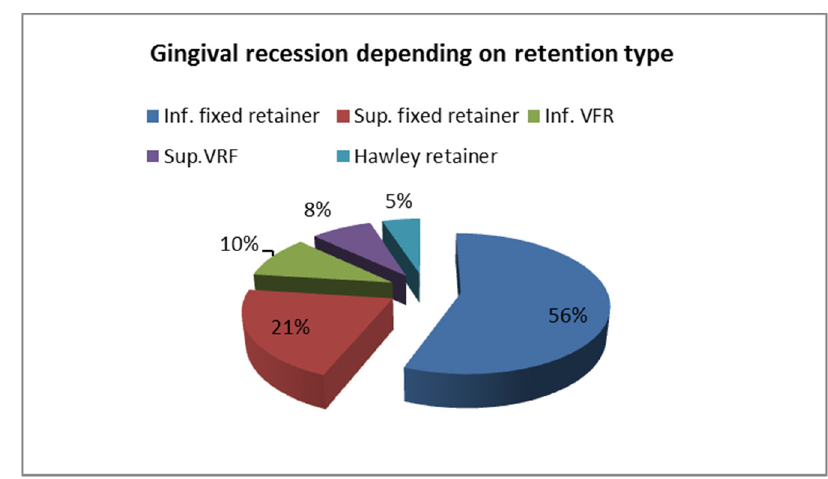
Figure 11. Gingival recession, female group.